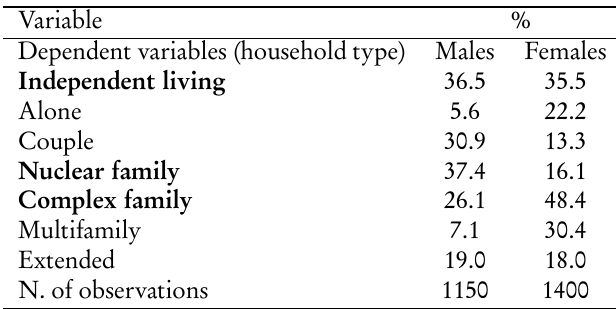
Multinomial logistic regression analysis. Dependent variables: percentage distribution. People 65 years and over, Egypt 2012. Notes: We did not include elderly whose living form was not precisely determined. Unweighted